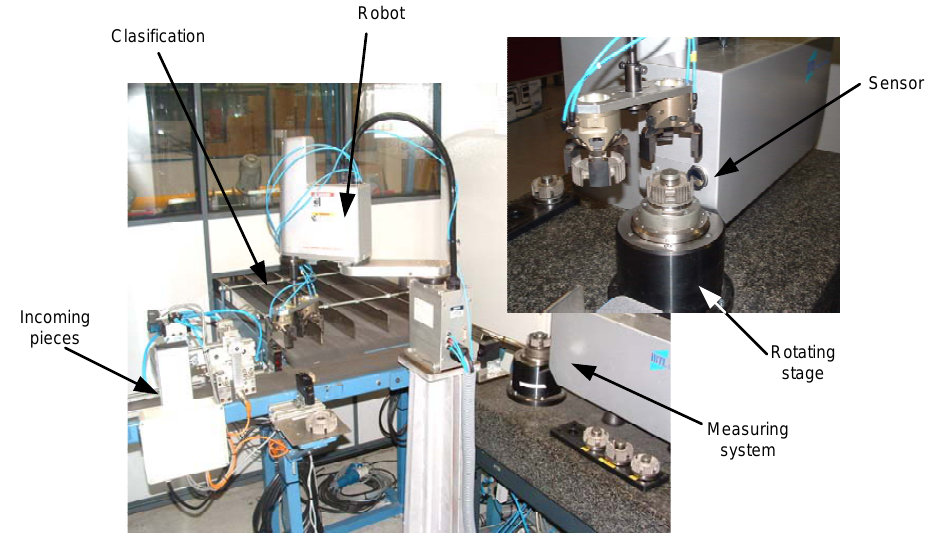
Figure 4. On-line measuring system and classification of synchronizer hubs, installed at PMG Asturias.